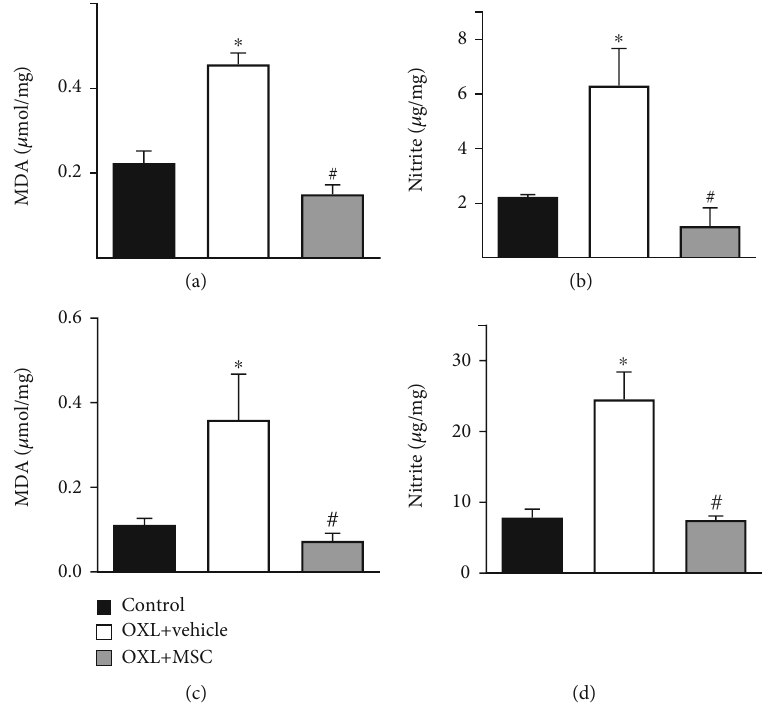
Figure 5: E ff ect of MSC on the levels of MDA and nitrite in the sciatic nerves and dorsal root ganglia of mice with OXL-induced chronic neuropathy. Two weeks after the OIPN model induction, mice were treated with 1 × 10 6 MSC (OXL+MSC) or vehicle (OXL+vehicle) by endovenous route. Control group received 5% dextrose instead of OXL. The levels of MDA and nitrite in the sciatic nerve (a, b, respectively) and DRG (c, d, respectively) were measured 4 weeks after treatment. Data are expressed as means ± standard deviation ; n = 6 mice per group. ∗ Statistical signi fi cance relative to the control group ( p < 0 : 01 ); # statistical signi fi cance relative to the OXL+vehicle group ( p < 0 : 001 ), as determined by one-way ANOVA followed by Tukey ’ s multiple comparison